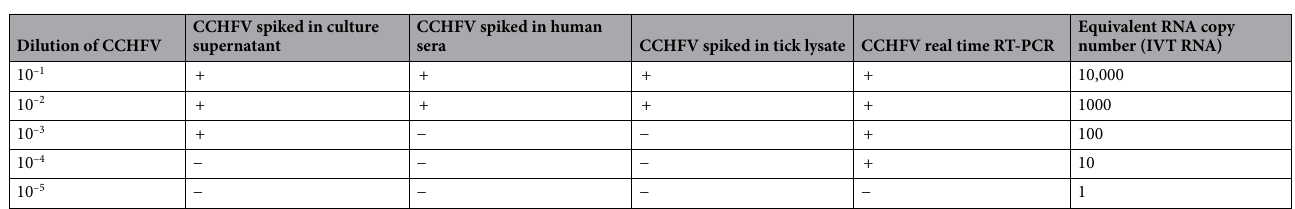
Table 2. Comparative evaluation of in-house developed sELISA in different matrices with real time RT-PCR assay.